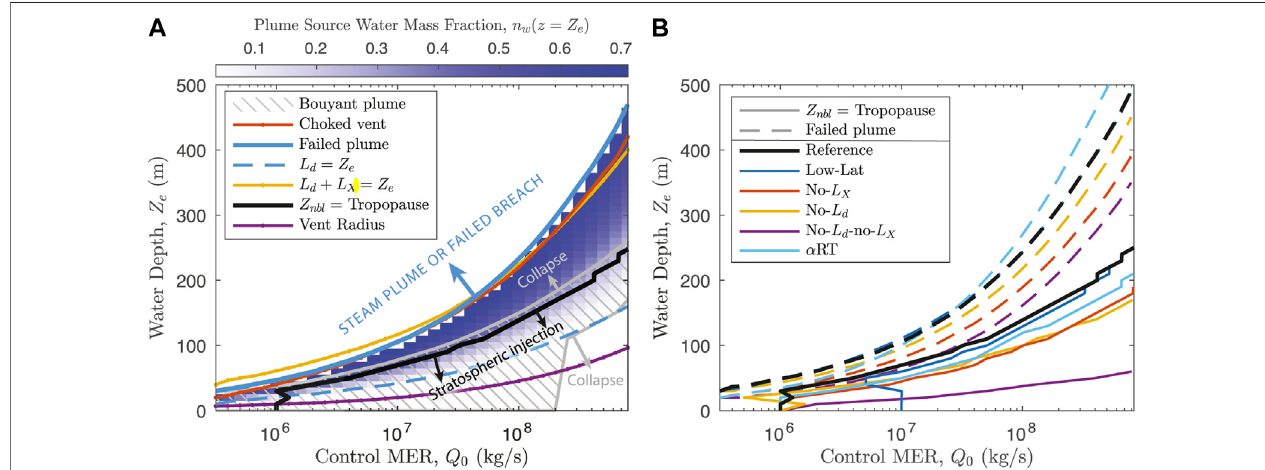
FIGURE 9 | (A) Plume source water mass fraction as a function of MER and water depth, with overlaid thresholds for behavior of the coupled conduit-plume system. The red line marks the threshold for which the vent is choked and overpressured, with pressure-balanced, subsonic jets occurring at deeper depths. The decompression lengthisequaltowaterdepthat theblue dashedline,whichisthedepthabove whichwaterentrainment begins.Buoyantcolumnsoccurwithinthegrey hatched region, with column collapse elsewhere. The steam plume threshold is marked by the solid blue line - failed plumes with only negligibly small amounts of steam reachthewatersurfacefordepthsgreaterthanthis(indicated bythebluearrow).Finally,thesolidblacklinemarksthewaterdepthabovewhichbouyantcolumns breach the tropopause. (B) Variation in the critical MER to reach the tropopause (solid lines) and maximum water depth before plume failure (i.e. the steam plume condition, dashed lines) for different simulation scenarios (see Table 2 ). Black lines are for the Reference scenario (high latitude atmosphere), while blue lines are for the low latitude atmosphere. The remaining colors are for the four scenarios with different water entrainment parameterizations: no mixing length ( No-L X , red), no decompressionlength( No-L d ,yellow),neithermixinglengthnordecompressionlength( No-L X -no-L X ,purple),andtheweightedRayleigh-Taylorentrainmentmode( α RT , light